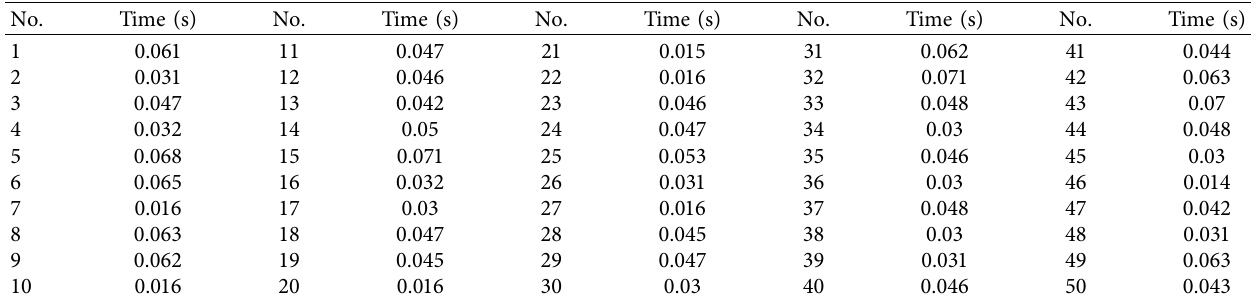
Table 7: The calculating time of the designed